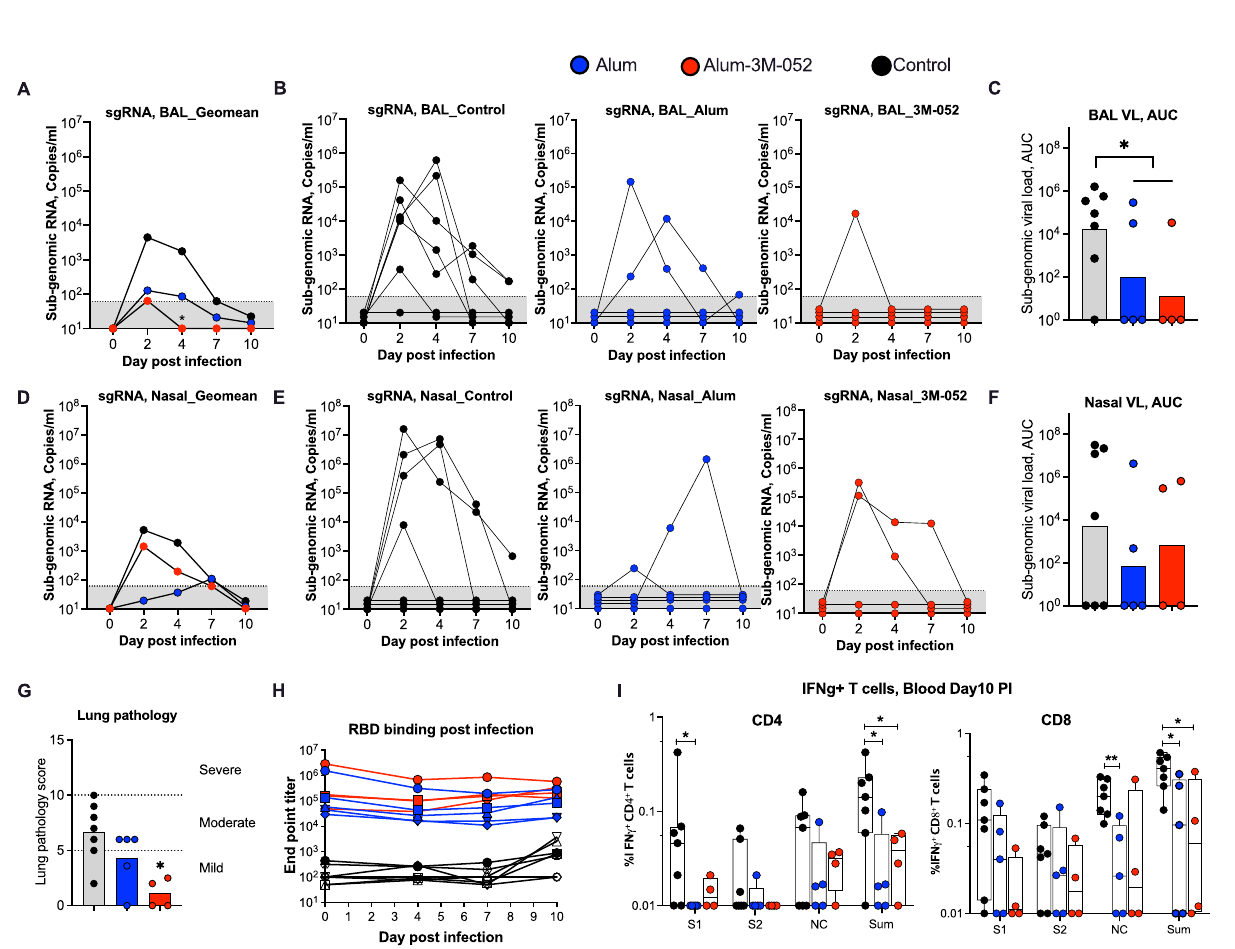
Fig. 4 Alum-3M-052 induces better innate activation compared to Alum in macaques. A Flow cytometry gating strategy used to identify various innate cells in blood. Live cells were selected using live/dead marker and CD3 + and CD20 + cells were excluded. Then, different innate cells were de fi ned using the following combination of markers. B and C Frequencies of various innate cells ( B ), Monocytes (HLA-DR + ) — classical (CD14 + ), intermediate (CD14 + and CD16 + ) and non-classical (CD16 + ); PDCs (HLADR + CD14 − CD16 − CD123 + BDCA1 − ); BDCA1 + DC (HLADR + CD14 − CD16 − CD123 − BDCA1 + ); MDCs (HLADR + CD14 − CD16 − CD123 − CD11c + ); M-MDSC cells (HLADR − CD14 + CD11b + ); PMN-MDSC cells (HLADR − CD14 − CD11b + ) and NK cells (HLADR − NKG2A + ); and CD86 + activation ( C ). NK natural killer cells, PDC plasmacytoid dendritic cells, MDC myeloid-derived dendritic cells, myeloid- derived suppressor cells (MDSC), polymorphonuclear (PMN) — MDSC, and monocytic (M) — MDSC. Groups were color-coded; Alum: Blue, Alum-3M-052: Red. Bars and columns show mean responses in each group ± SEM; Statistical signi fi cance was measured using two-tailed paired t -test for comparisons within the group and two-tailed un-paired parametric t -test for comparisons between the groups. Asterisks denote statistical signi fi cance ∗ p < 0.05 and ** p < 0.01.